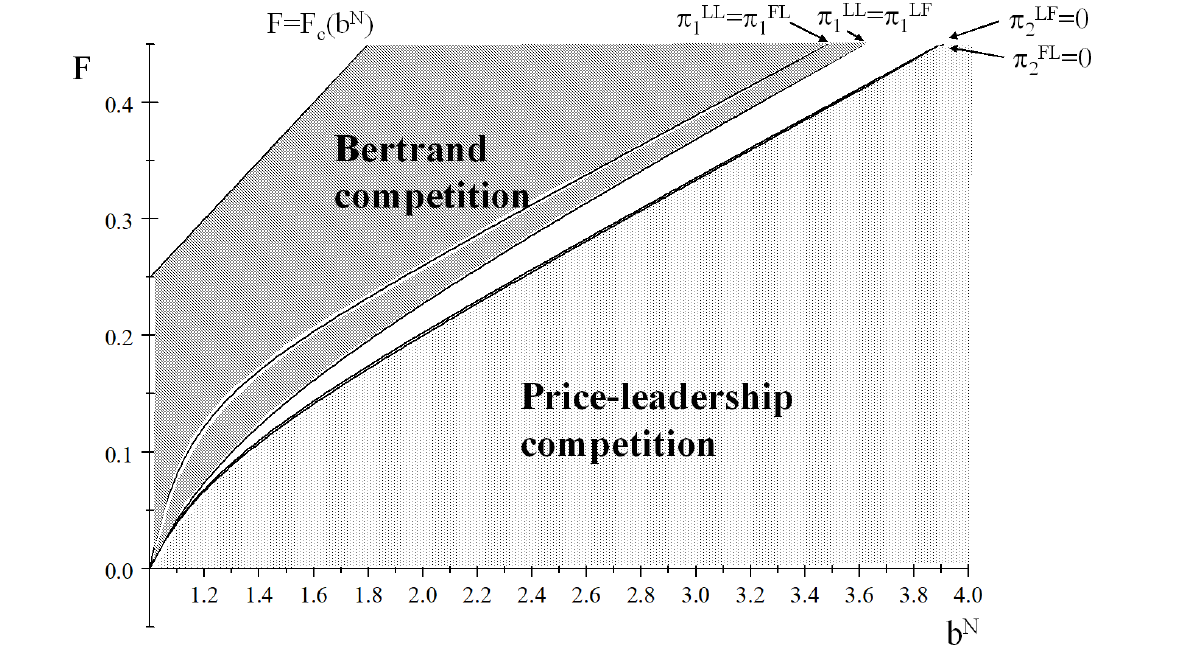
Figure 2. The type of competition in case of c =